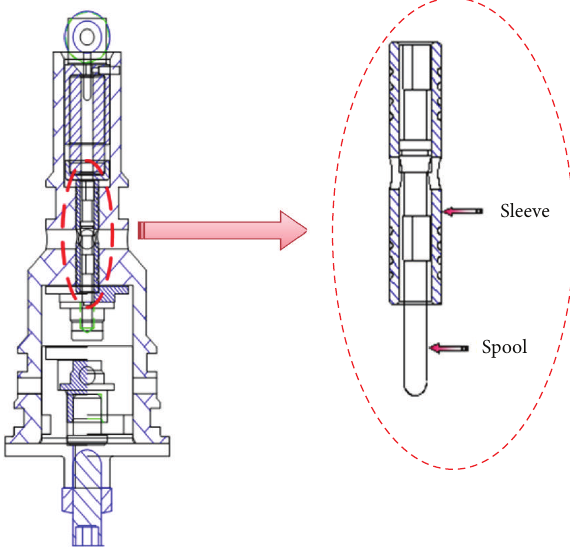
Figure 3: Regulator assembly of constant power regulator.